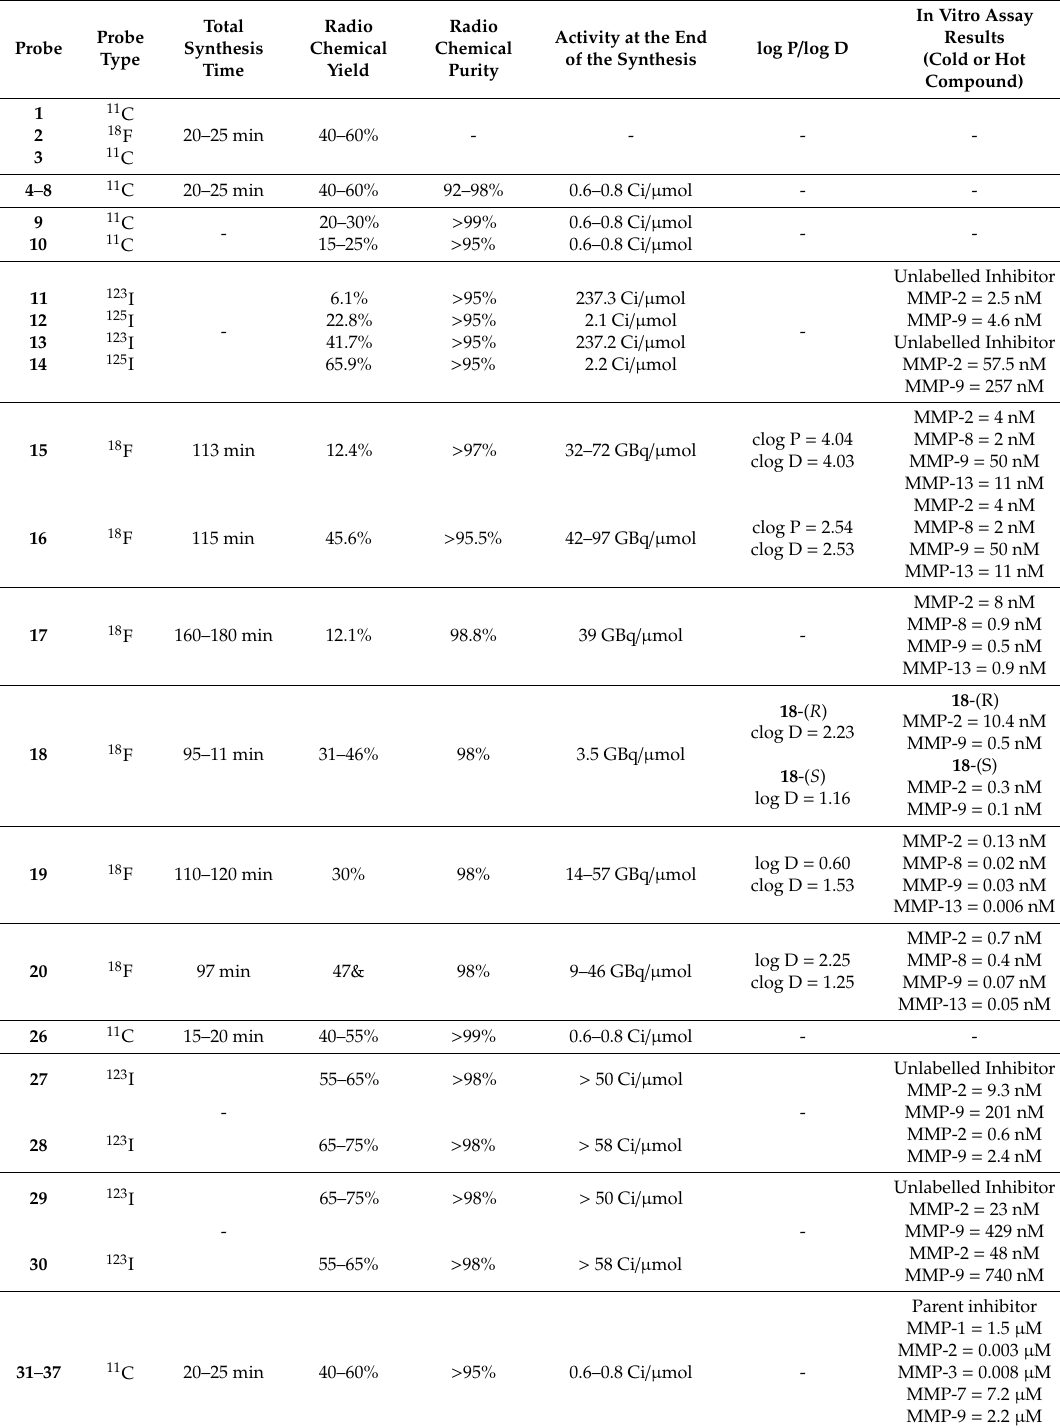
Table 2. The experimental details in the radiosynthesis of matrix metalloproteinases inhibitors (MMPIs) based imaging